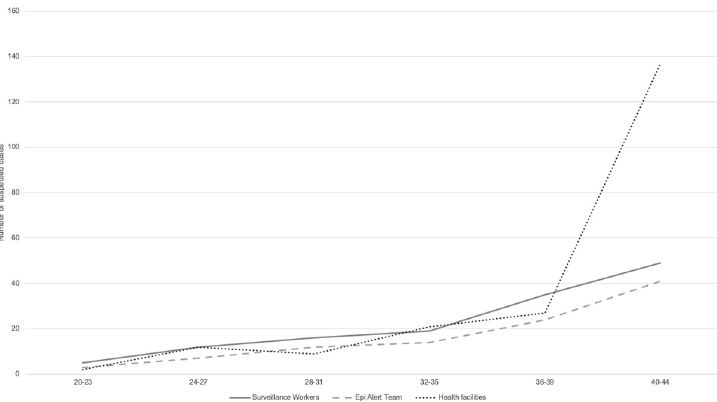
Fig 7. Trends in suspected measles cases compared between two MSF health facilities, surveillance workers and Epi Alert Team in Cox’s Bazar, Bangladesh, week 20–44, 2019.